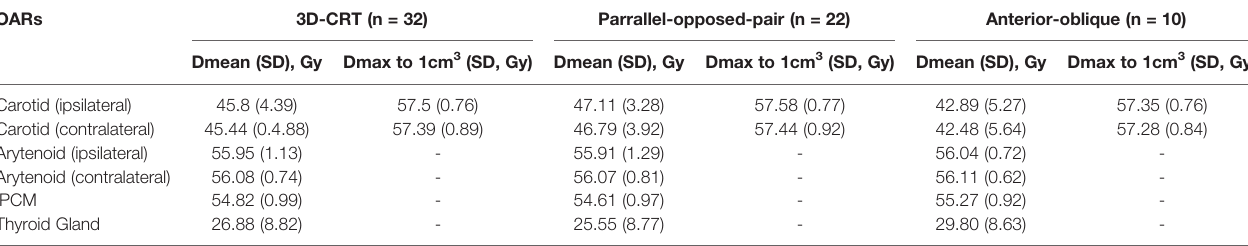
TABLE 1 | Dose statistics analysed for 32 patients treated with 3D-CRT at Royal Marsden Hospital, Sutton. OARs 3D-CRT (n =